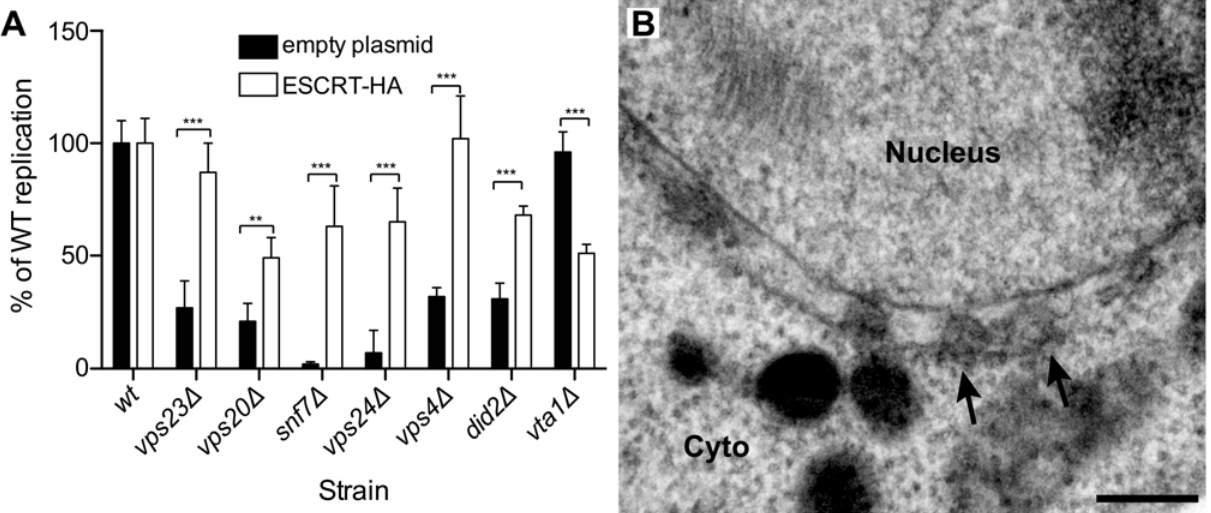
Fig 6. BMV RNA replication is restored in ESCRT deletion strains by supplementing HA-tagged ESCRT proteins expressed from their endogenous promoters. (A) Wt or ESCRT deletion strains were transformed with plasmids expressing 1a, 2a pol , RNA3 and either an empty plasmid or plasmids encoding the HA-tagged ESCRT proteins. Total RNA was extracted and accumulation of positive-strand subgenomic RNA4 was measured by Northern blotting. Values represent the mean and standard deviation of three independent experiments. *** p < 0.001. (B) Representative EM image of snf7 Δ yeast expressing 1a, 2a pol , RNA3 and Snf7p-HA. Scale bar: 200